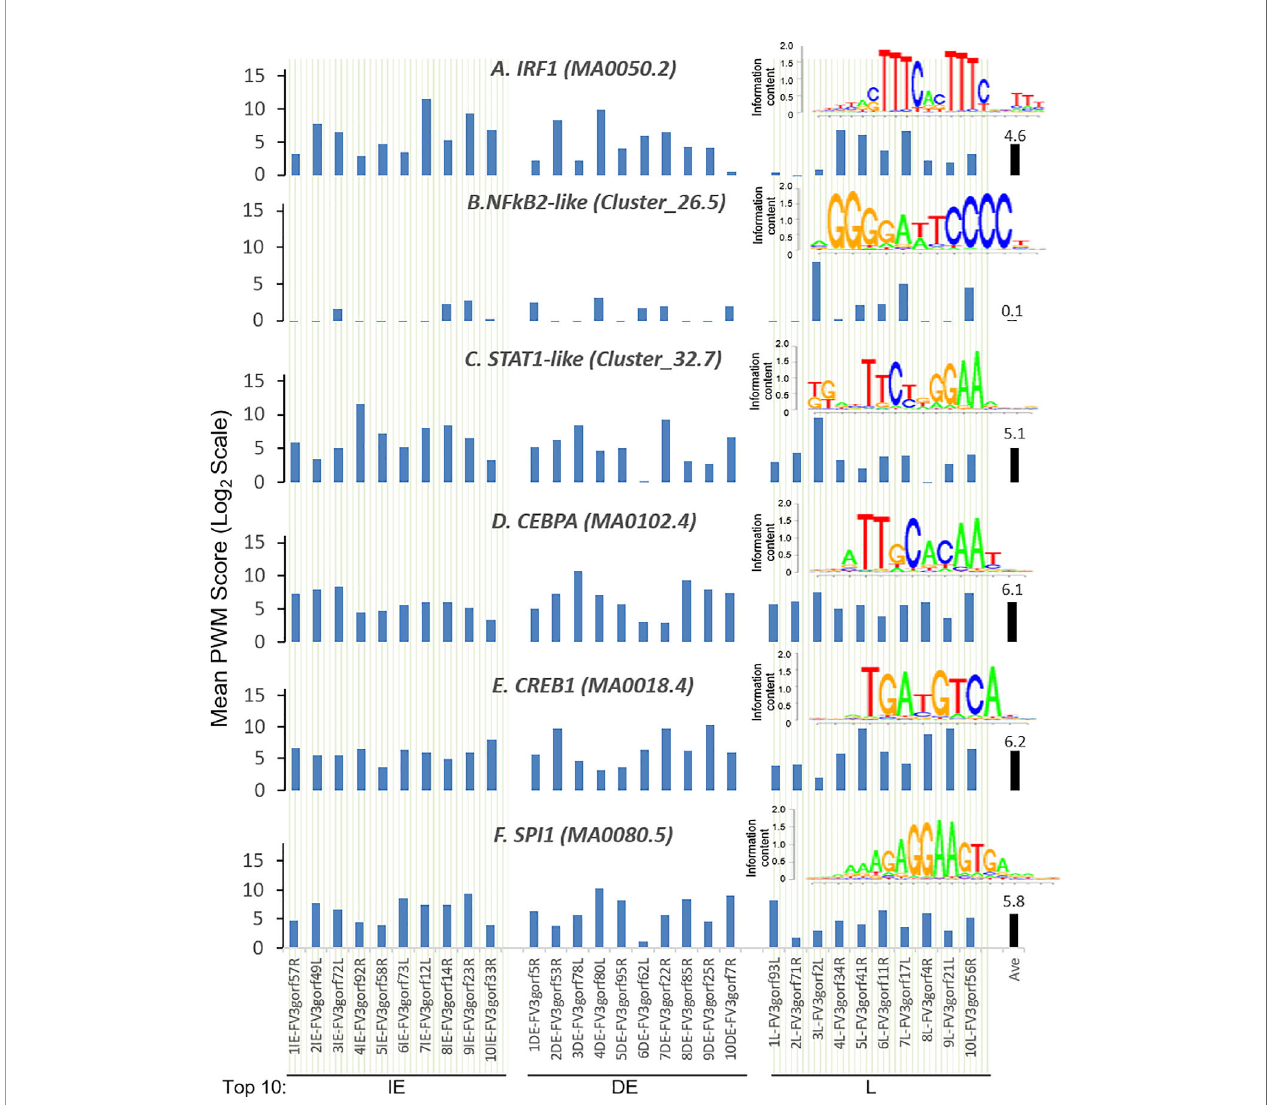
FIGURE 4 | Intergenic regions immediately upstream of highly expressed FV3 genes serve as putative core promoters with enhanced capacity to bind vertebrate transcription factors of (A) IRFs, (B) NF- k B2-like, and (C) STAT1-like, but not much enhanced for (D) CEBPA, (E) CREB1, and (F) SPI1 transcription factors. Shown are mean PWM scores of cis -regulatory elements (CREs) in FV3 intergenic regions that are immediately upstream of top-ten highly expressed FV3 coding genes (ORFs) in each temporal class of immediate early (IE), delay early (DE), or late (L) genes. Mean PWM scores were calculated using tools at https://ccg.ep fl .ch/ pwmtools/pwmscore.php with CRE Matrices are from MEME-derived JASPAR CORE 2020 vertebrates or JASPAR CORE 2018 vertebrates clustering af fi liated with the PWM tools. The cross-panel average mPWM scores (Ave) of each CRE are shown as data-labeled black bars at the right for overall comparison. Abbreviations of TFs are as in Figure 3